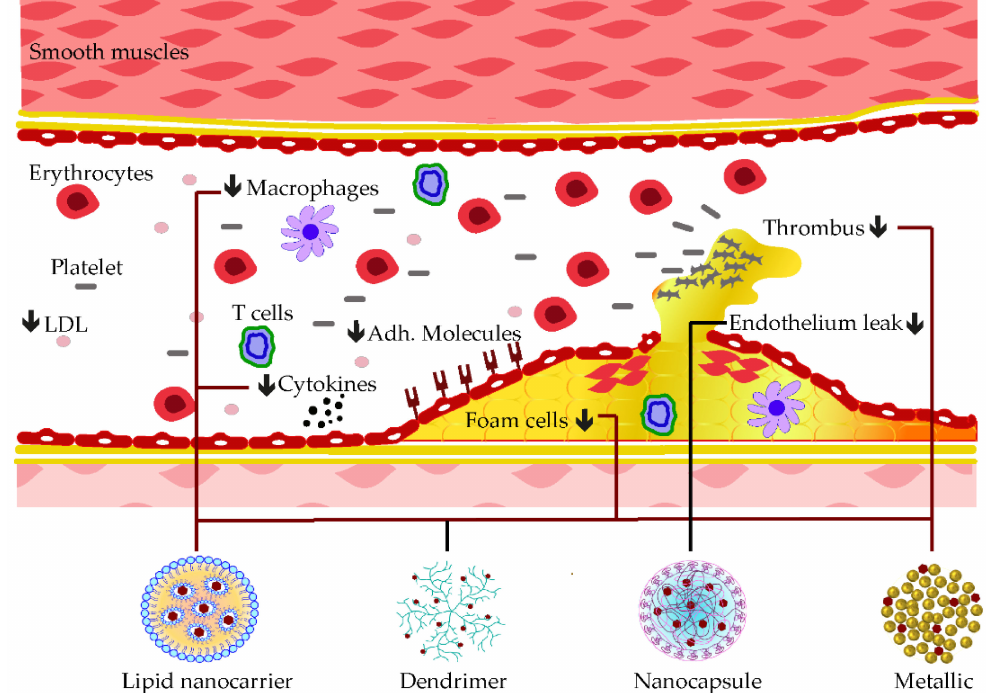
Figure 6. Examples of nanocarrier delivery of polyphenolics and their targets in Atherosclerosis. The black arrows down signify the decreasing effects. The black dots consist of inflammatory cytokines. The bold lines match the nanocarriers and their respective